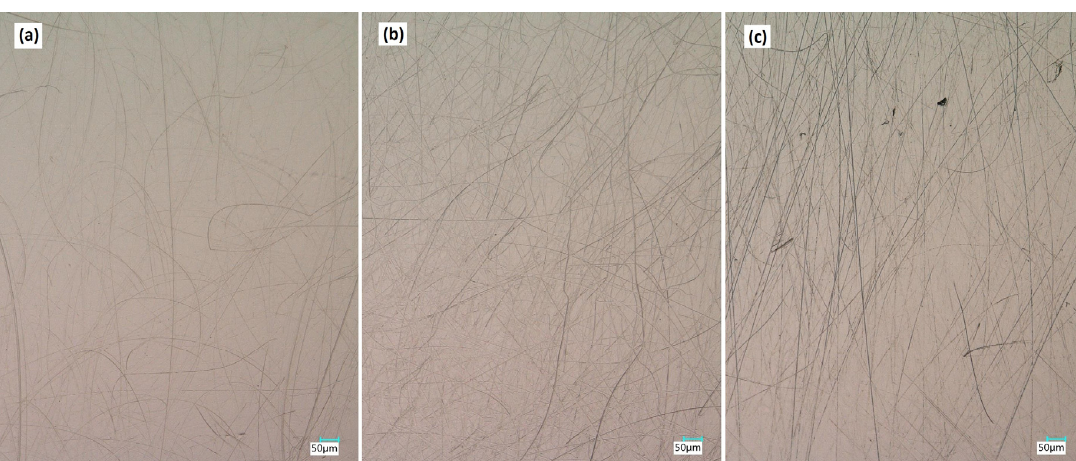
Table 6. Pairwise Comparison between all 3 Groups (Spacer, PE-Short, PE-Long).